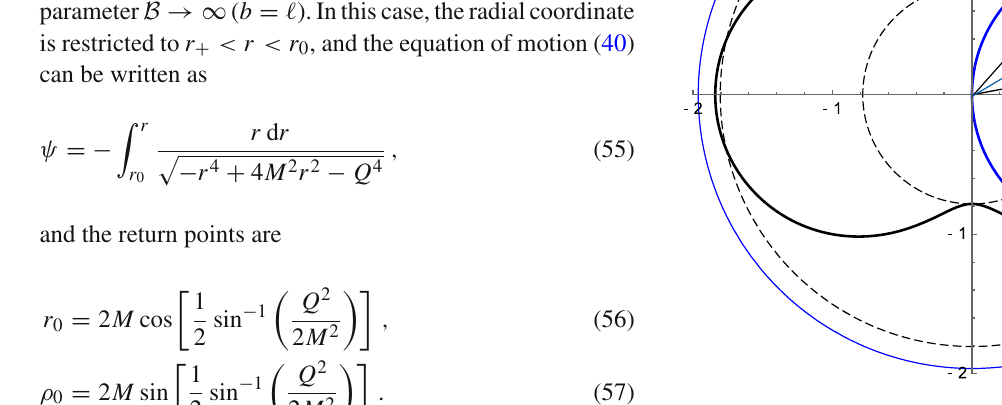
Fig. 7 The hippopede geodesic (black line), with E (cid:4) = 0 . 01, Q = 1 . 20, and (cid:4) = 10, dashed black lines correspond to the horizons. The circumference geodesic (blue lines), with E (cid:4) = 0 . 01, Q = 0, and (cid:4) = 10